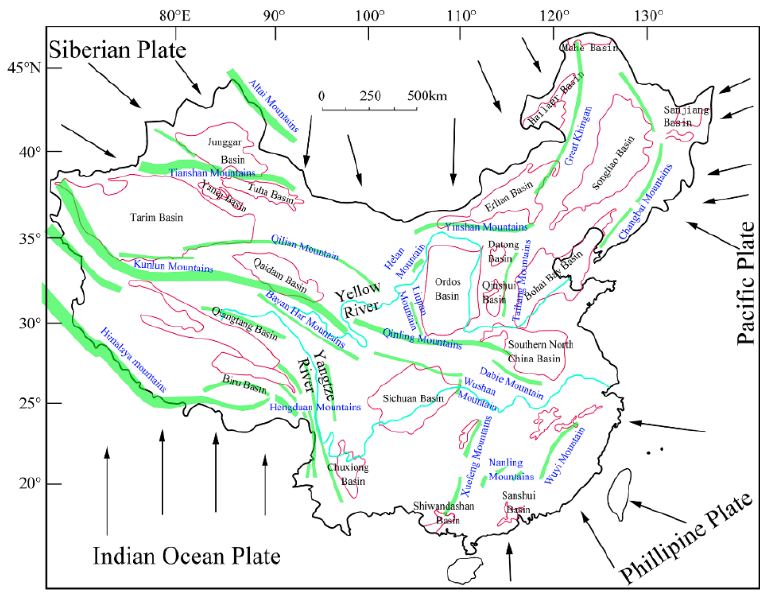
Figure 2. Large coal ‐ bearing basins in China and their dominating mountains.